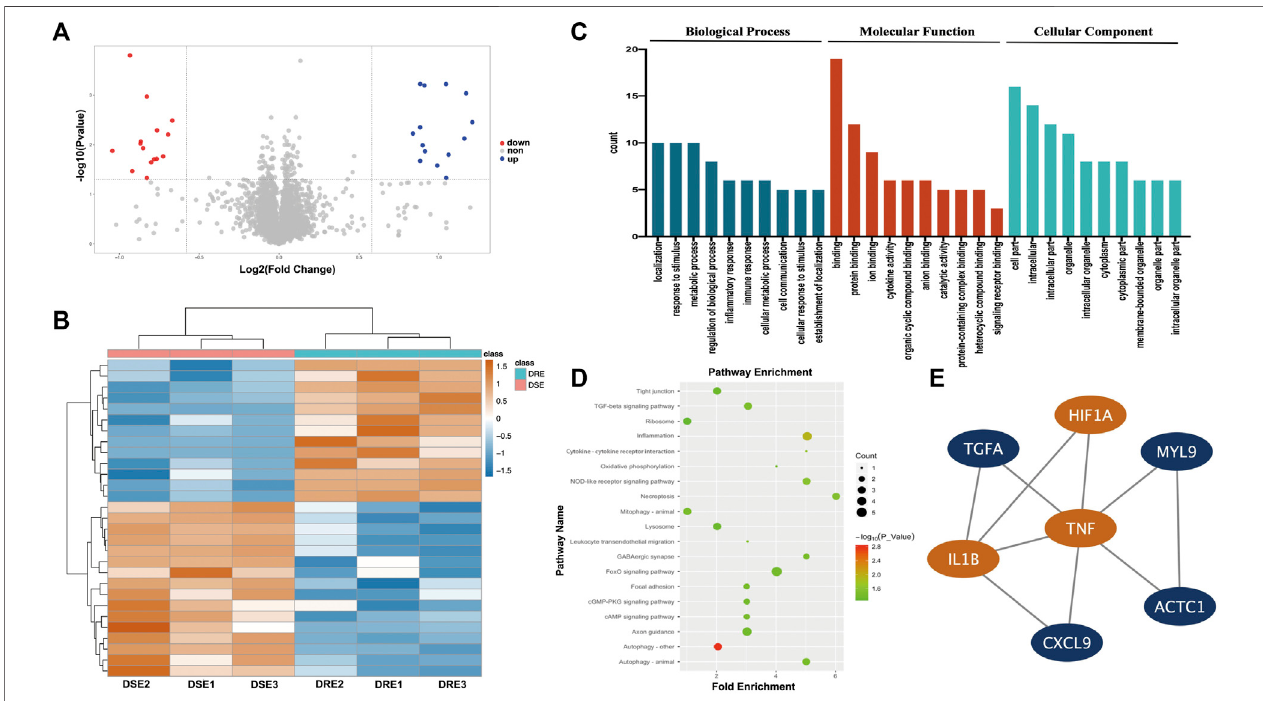
FIGURE 3 | Quantitative proteomics analysis of the hippocampus in mice. (A) Volcano plot of differentially expressed protein in hippocampus between VPA- resistant epilepsy and VPA-sensitive epilepsy. Red dots are down-regulated proteins. Blue dots are up-regulated proteins. (B) Heatmap of 29 differentially expressed proteininhippocampusbetweenVPA-resistantepilepsyandVPA-sensitiveepilepsy. (C) Thebiologicalprocess,molecularfunctionandfunctionalenrichmentanalysisof the differentially expressed proteins between the VPA-sensitive group and the VPA-resistant group through the GO database. (D) Differentially expressed proteins areenriched inmultiplein fl ammation-related signalingpathwaysusingtheKEGGdatabase. (E) Thetop1connectivitymodulecontainedHIF-1 α ,IL-1 β ,and TNF- α inthe PPI network of differentially expressed proteins. DSE: VPA-sensitive epilepsy, DRE: VPA-resistant epilepsy.